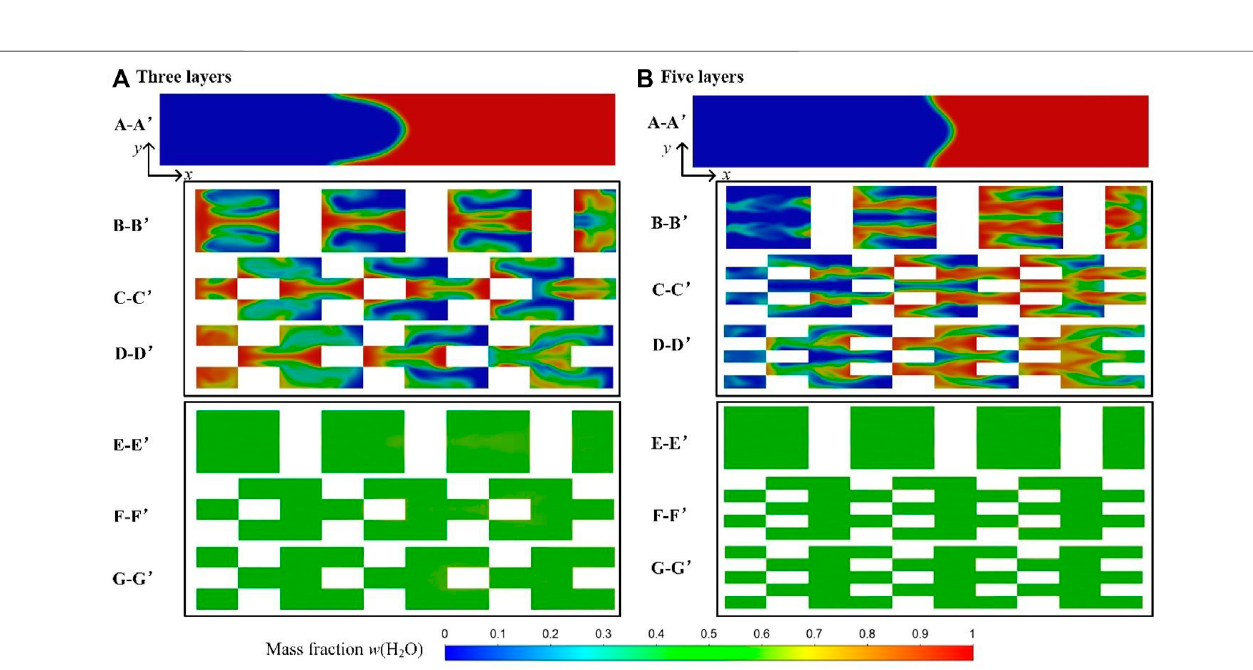
FIGURE 10 | Concentration distribution of water on x-y planes at R e (cid:1) 99: (A) three-layer inserts and (B) fi ve-layer inserts.